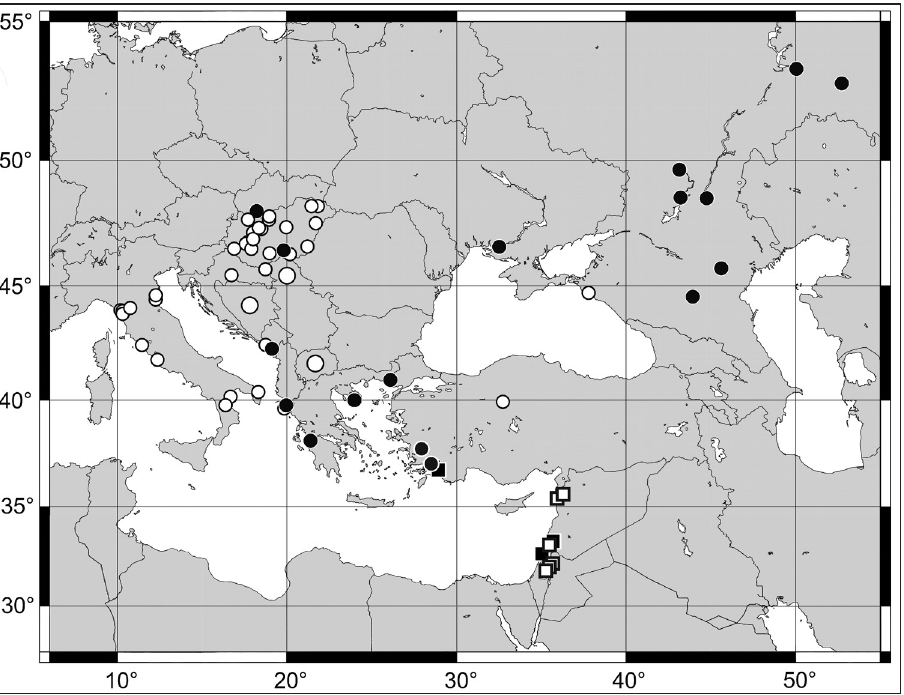
Figure 9. Map of distribution of H. anatolicus (circles, dots) and H. sanctus (squares). White symbols represent records from the literature, large circles represent imprecise data for a larger region (country); black symbols represent records of specimens examined by